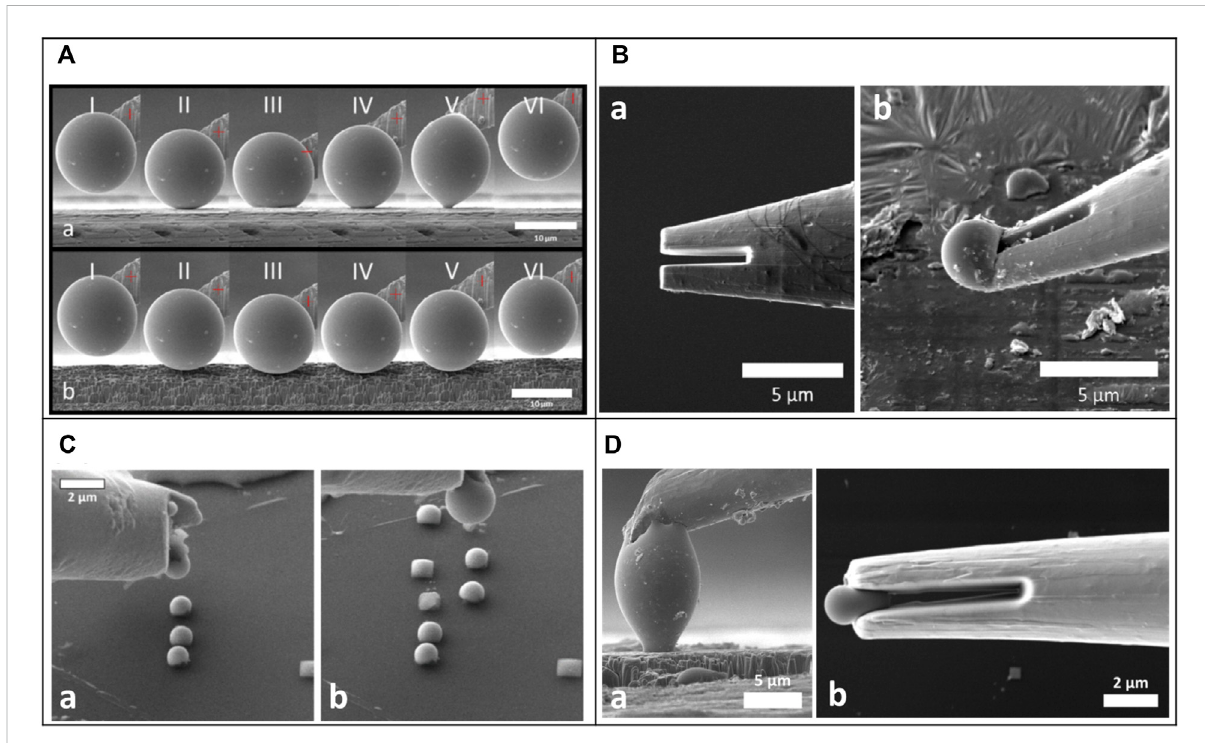
FIGURE 9 SEM micrographs of different liquid metal probers for contact applications. (A) Process of measuring different contact angles on a) a smooth surfaceandb)onaroughsurfacewithaliquidmetal(Galinstan)prober.Differenceinthecontactanglecharacteristicscanbeobserved.Adaptedwith permission from (Kleist-Retzow et al., 2020); (B) Manipulator a) before and b) after the fabrication of a liquid metal (gallium) prober for gripping processes by phase change are illustrated. Adapted with permission from (Kleist-Retzow von et al., 2019b); (C) Micrographs of a liquid metal prober (Galinstan) for placing of multiple liquid metal droplets on a surface are presented. Adapted with permission from (Kleist-Retzow von et al., 2019b); (D) SEMmicrographsoftwodifferentliquidmetalprobers(Galinstan)fora)contactanglemeasurementsandb)pickandplaceprocessesare presented. Adapted with permission from (Kleist-Retzow and von,